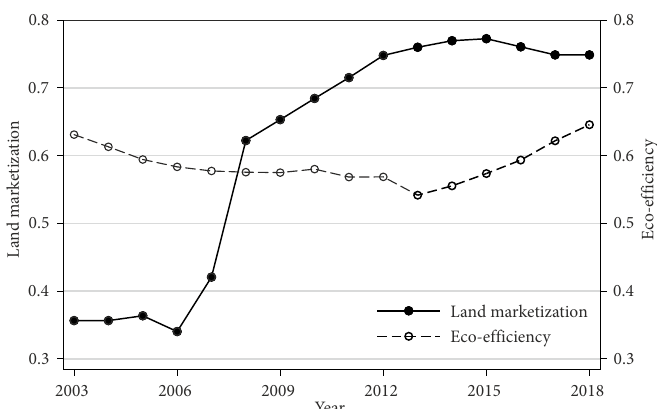
Figure 1. The trend of land marketization and eco-efficiency in Chinese cities during